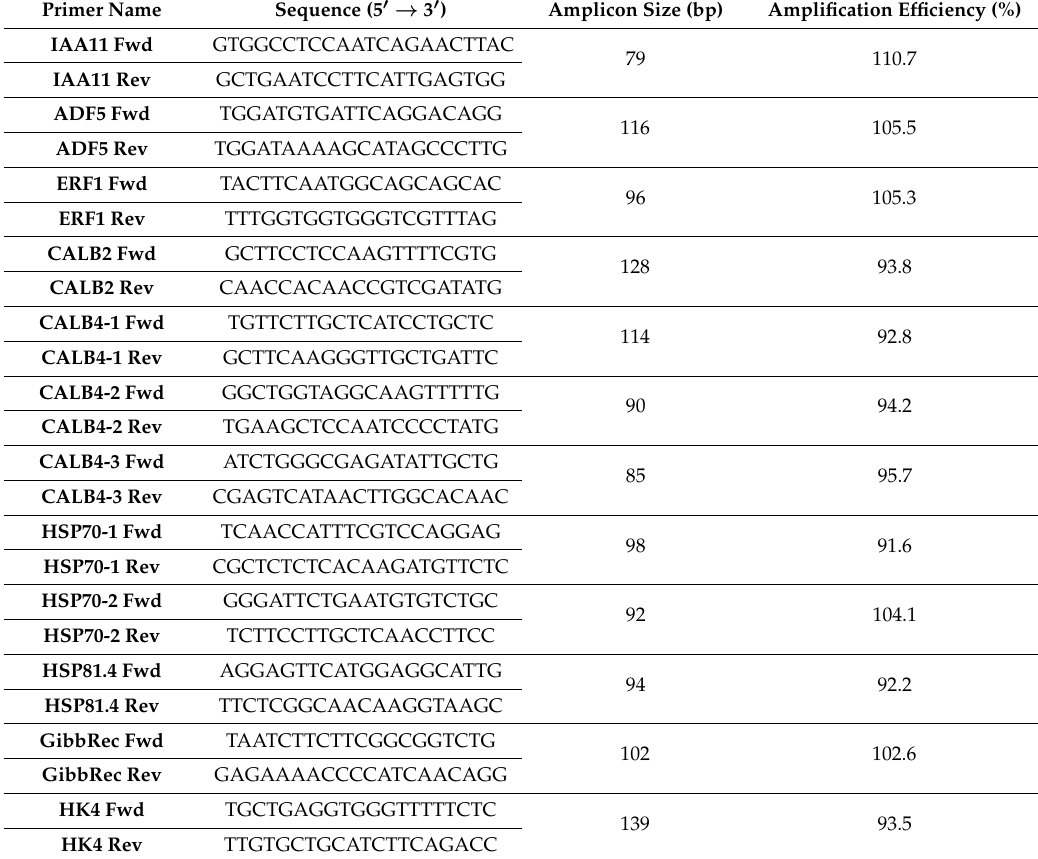
Table 1. List of primers used in the study, with details of the amplicon size and amplification